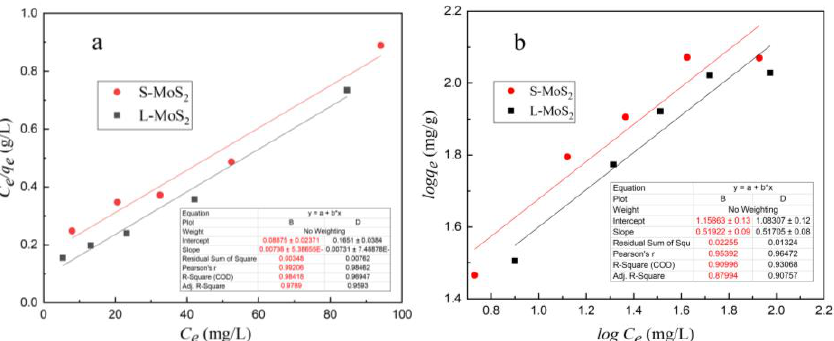
Figure 8. Pseudo-second-order kinetic models for S-MoS 2 and L-MoS 2 adsorption of Cu 2+ (The inserted chart: the parameter of the linear fitting).